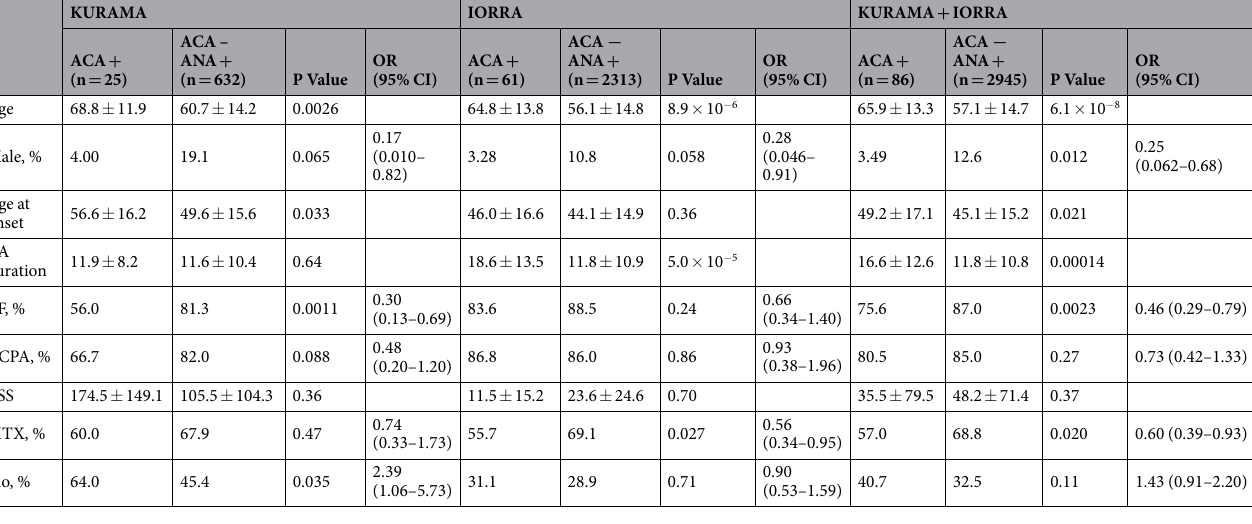
Table 2. Clinical features of ACA-positive RA patients among ANA-positive subjects. KURAMA, Kyoto University Rheumatoid Arthritis Management Alliance; IORRA, Institute of Rheumatology, Rheumatoid arthritis; ACA, anti-centromere antibody; OR, odds ratio; 95% CI, 95% confidence interval; RA, rheumatoid arthritis; TSS, total sharp score; DAS, disease activity score; ESR, erythrocyte sedimentation rate; MTX, methotrexate; Bio: biologic therapy. mean ± standard deviation is indicated for quantitative traits.